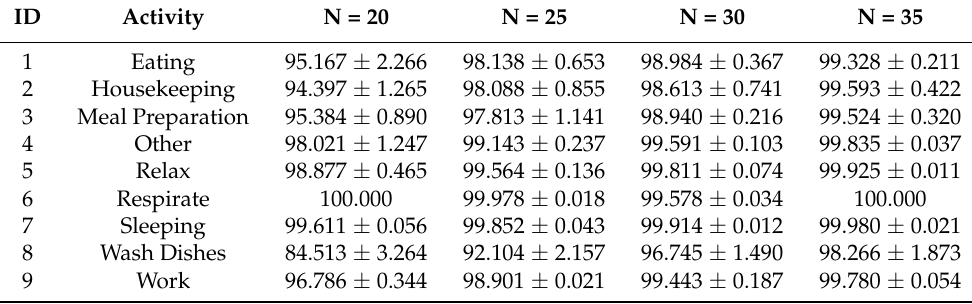
Table 5. The F 1 - score ( % ) (mean ± 3 σ ) of different activities of TLGAT in the ARUBA